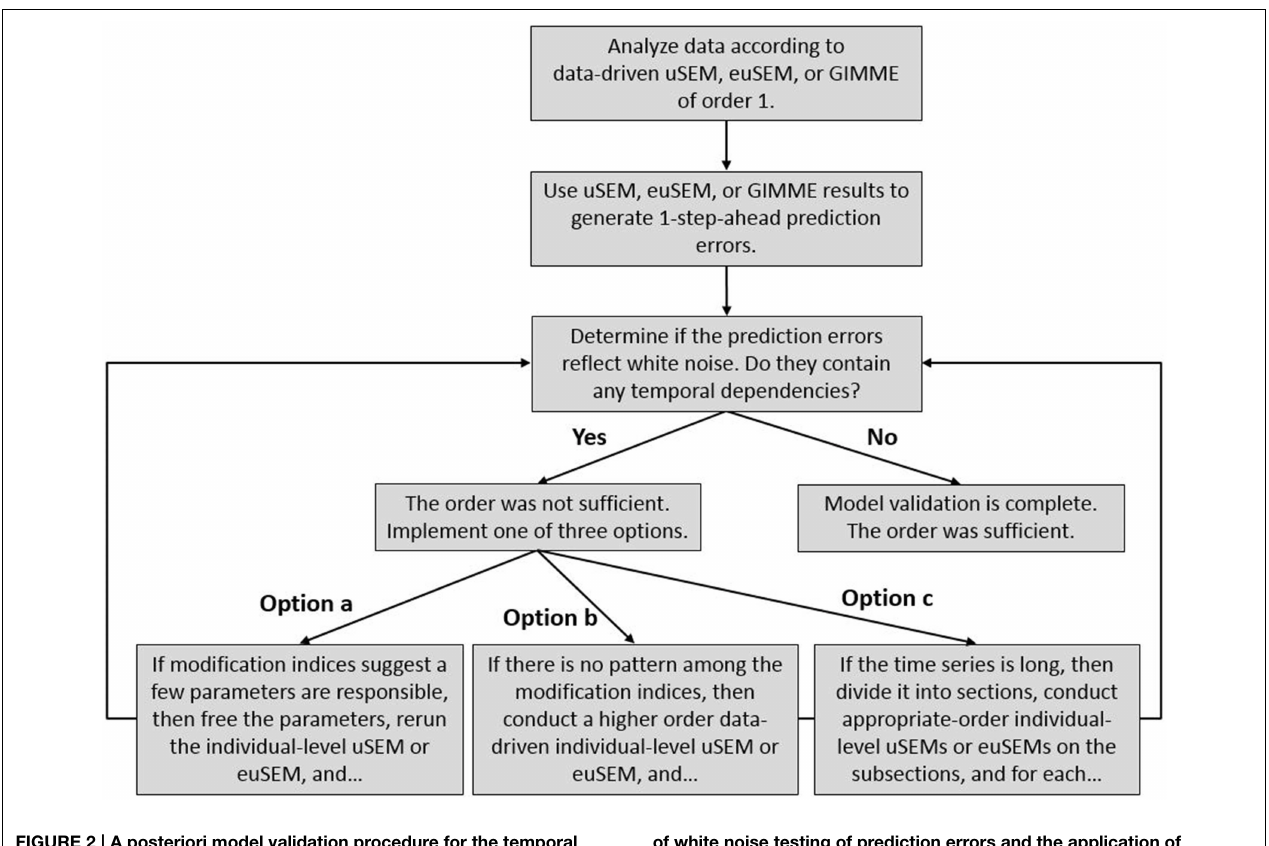
of white noise testing of prediction errors and the application of decision criteria for generating higher order individual-level maps, when